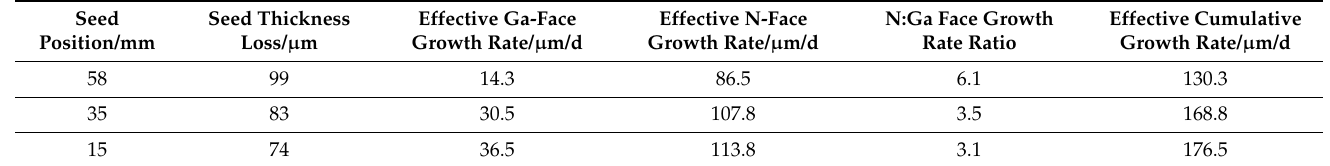
Table 8. Results of the growth experiment. Note that face-specific growth rates refer to the polarity of the seed, which could potentially differ from the polarity of the grown layer in case of polarity inversion. Note as well that the bottom edges of the bottom seed (position 15 mm) dissolved. Note that growth rates were determined based on the duration of constant growth stage set temperatures, which is only an approximation of the actual timespan during which growth